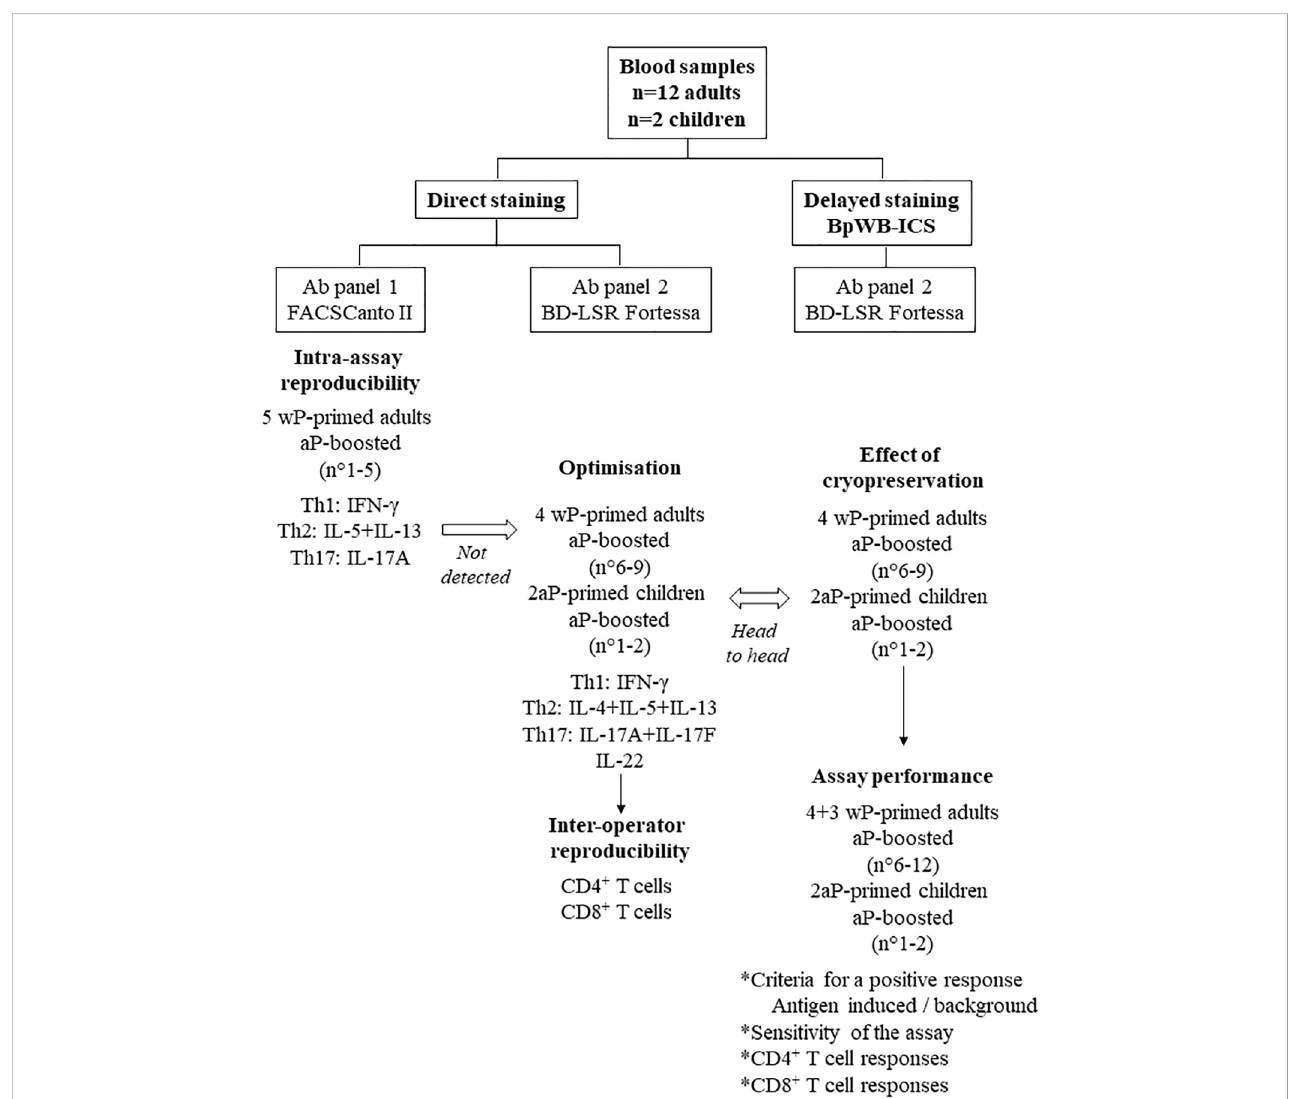
FIGURE 1 Flow chart of the study with the different steps of development of the BpWB-ICS. Blood samples were collected from 12 adults and from two children. The adults were all primed with a whole-cell pertussis vaccine (wP), whereas the children were primed with an acellular pertussis vaccine (aP). All the subjects were aP boosted. The intra-assay reproducibility was fi rst evaluated on blood samples from fi ve adults, using a direct staining of the Bp-antigen- stimulated cells. As antigen-speci fi c Th2 cells were not detected, further optimisation was performed on blood samples from four adults and from two children. The antibody panel 2 was determined, a BD-LSR Fortessa replaced the FACSCanto II, and the inter-operator reproducibility was evaluated. Results obtained for the same blood samples were analysed head to head without and after a cryopreservation step to develop the BpWB-ICS with a delayed staining of the cells. This allowed us to further analyse the assay performance of the